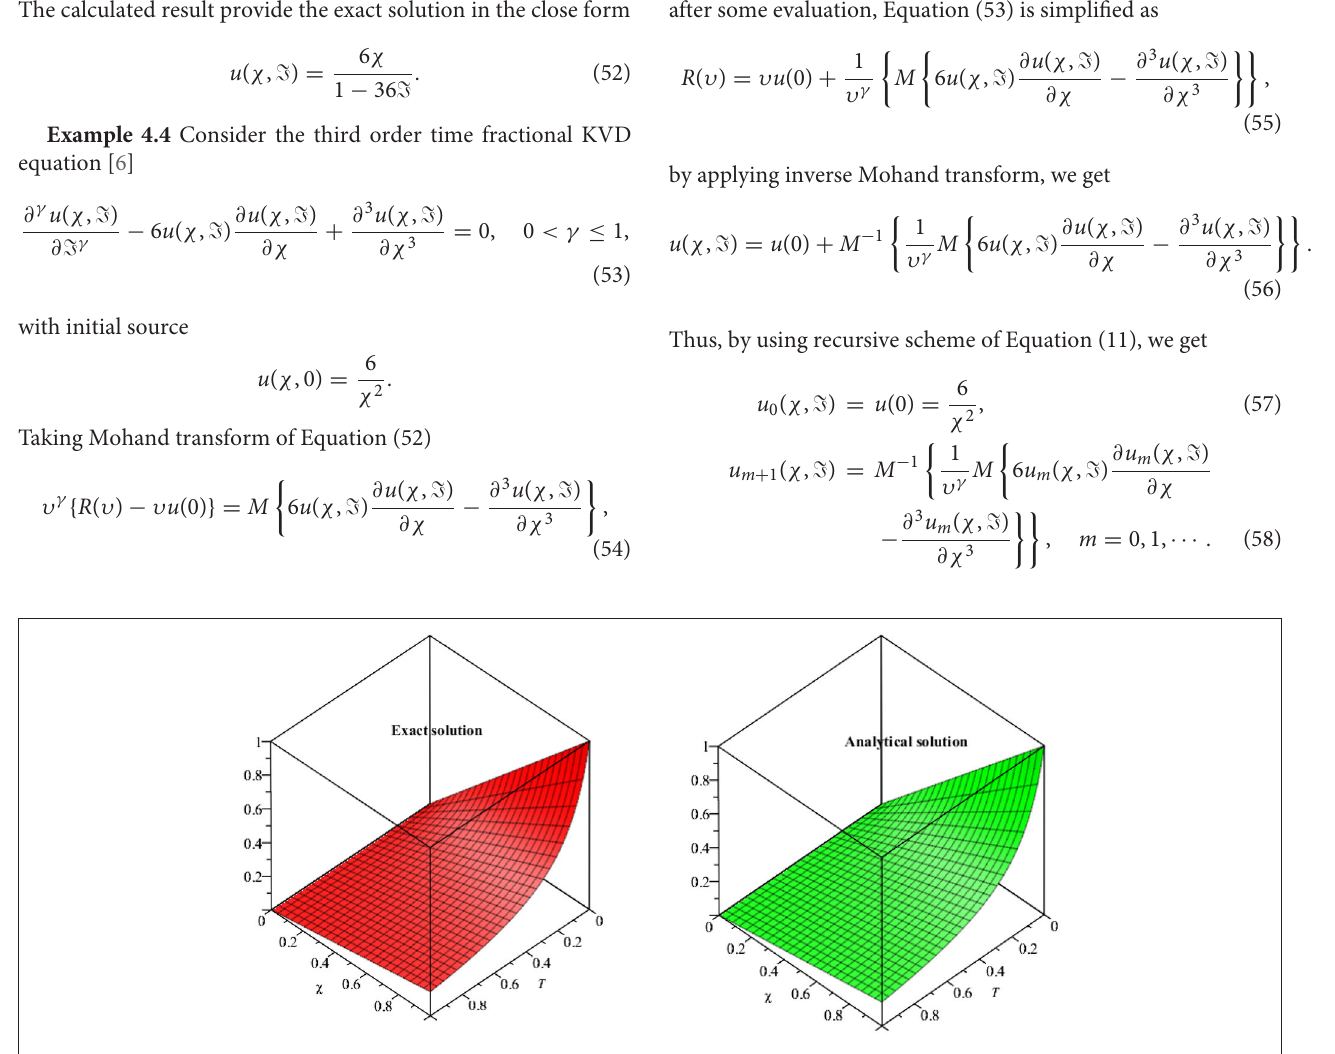
FIGURE 1 | Represents the exact and analytical solution of example 4.1.